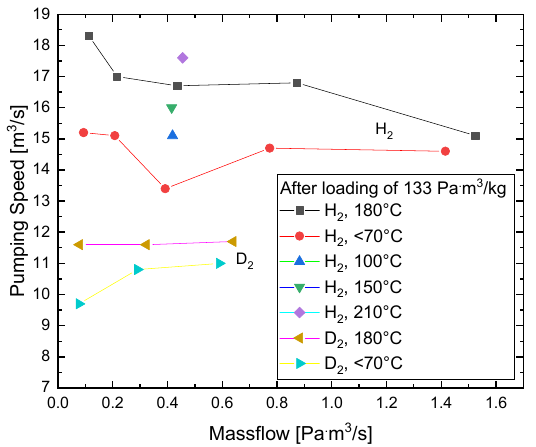
Figure 17. Full map of the pumping speed results for a getter loaded only with 133 Pa·m 3 /kg under different mass flows, getter temperatures and isotopes.